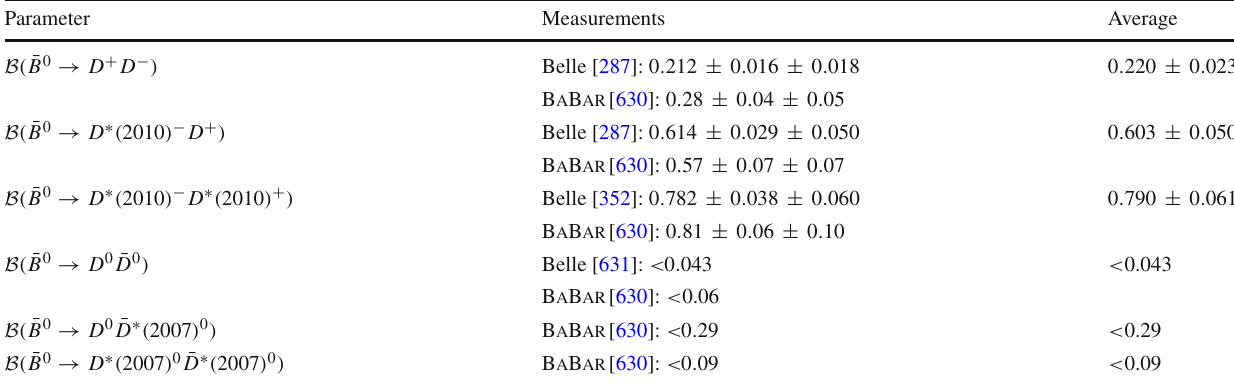
Table 106 Decays to D ( ∗ ) + D ( ∗ ) − [ 10 − 3 ] Parameter Measurements Average